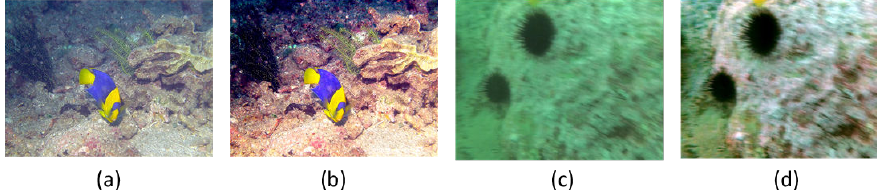
Figure 15. Some failure examples. ( a ) an underwater image taken under the artificial light; ( b ) our result; ( c ) a blurry underwater image induced by water fluctuation; ( d ) our